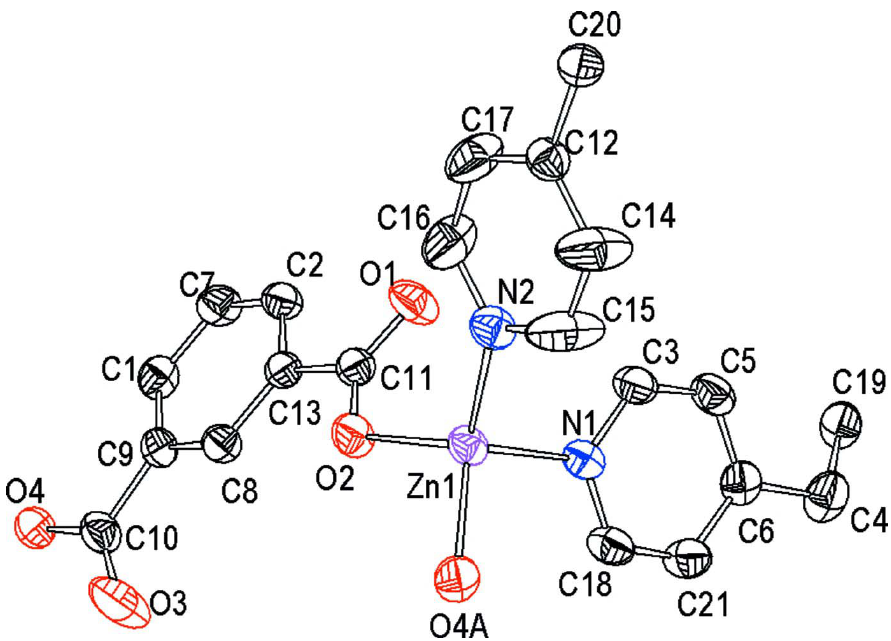
Figure 1 The asymmetric unit showing 30% probability displacement ellipsoids. A symmetry related O atom is shown to complete the tetrahedral coordination [symmetry code: (A) x , 5/2 - y , 1/2 + z ]. H atoms are not shown.